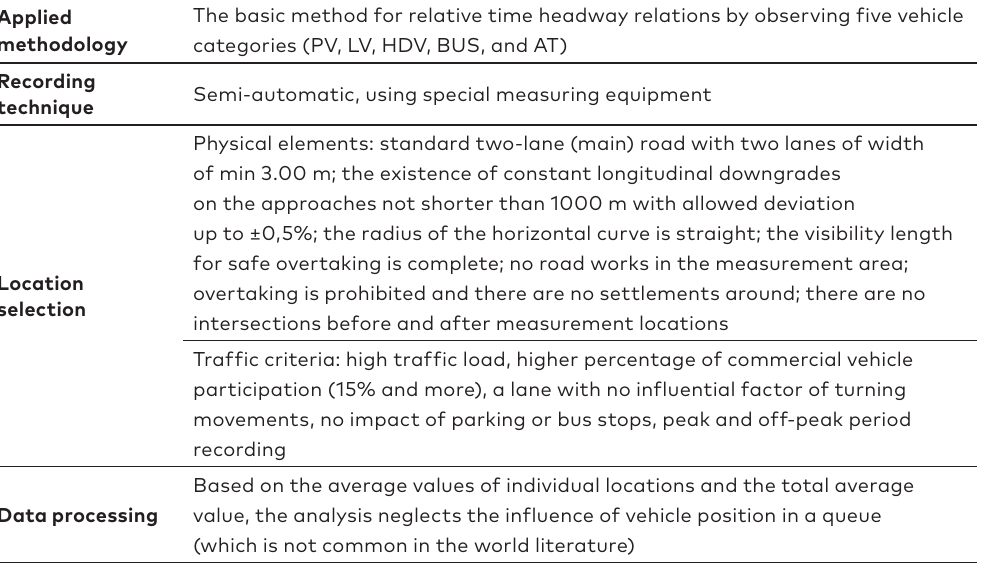
Table 1. Summary of methodological settings applied in the